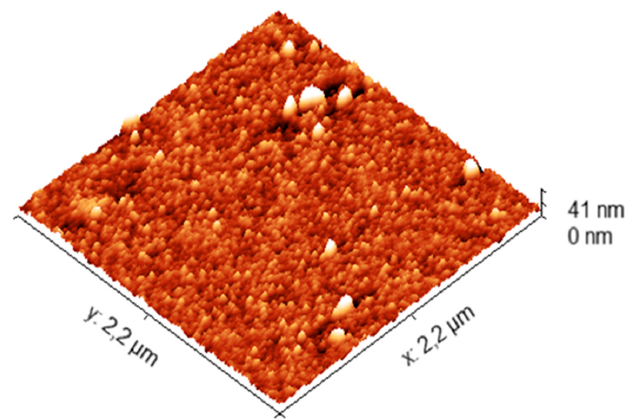
Figure 8. Atomic Force Microscopy imaging of empty polymer particles.